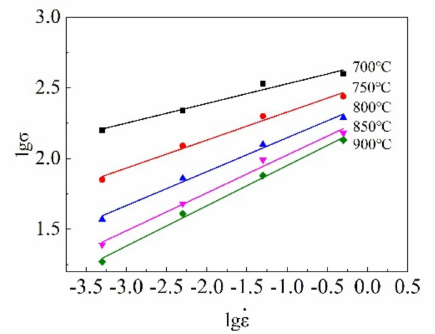
. ε Figure 5. lg σ -lg curve of Ti-6Mo-5V-3Al-2Fe alloy at different temperatures. Table 2. The m value of Ti-6Mo-5V-3Al-2Fe alloy at different temperatures ( ε =